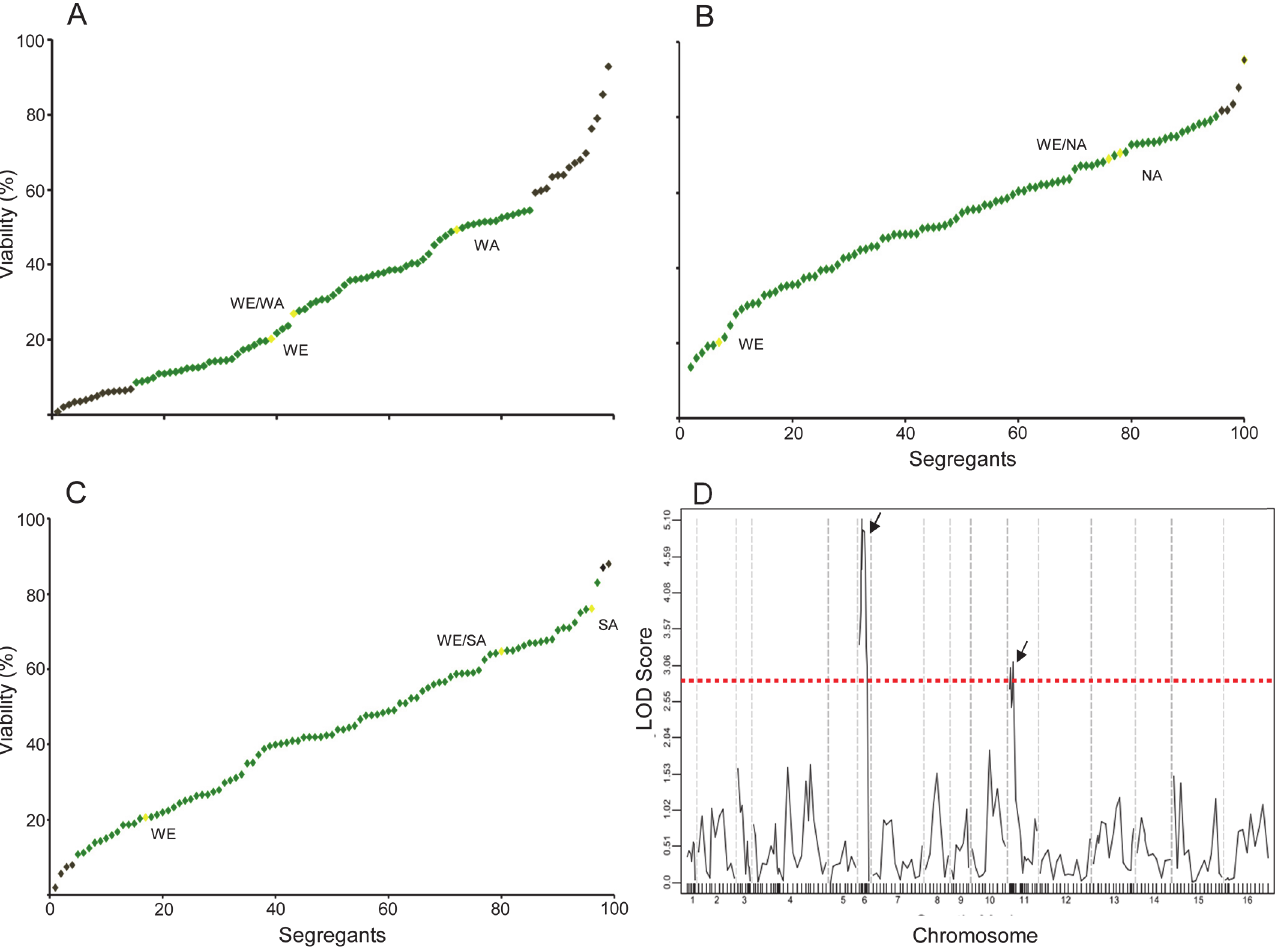
Fig 1. Viability rate variation after dehydration stress. Viability rate values are shown on the y -axis for the 96 ranked segregants of the WE x WA cross (A), WE x NA cross (B), and WE x SA cross (C). Dots indicate segregants with transgressive phenotypes (exceeding two parental standard deviations, black), parental and hybrid strains (yellow), and segregants within the phenotypic range of the parental strains (green). D) Linkage analysis for dehydration stress tolerance from WE/WA segregants. The chromosomes are displayed on the x -axis, and LOD viability values, according to each molecular marker across the 16 yeast chromosomes, are displayed on the y -axis. The significant LOD score threshold is indicated by a red line and was determined by a permutation test. The significant QTLs are indicated by arrows.